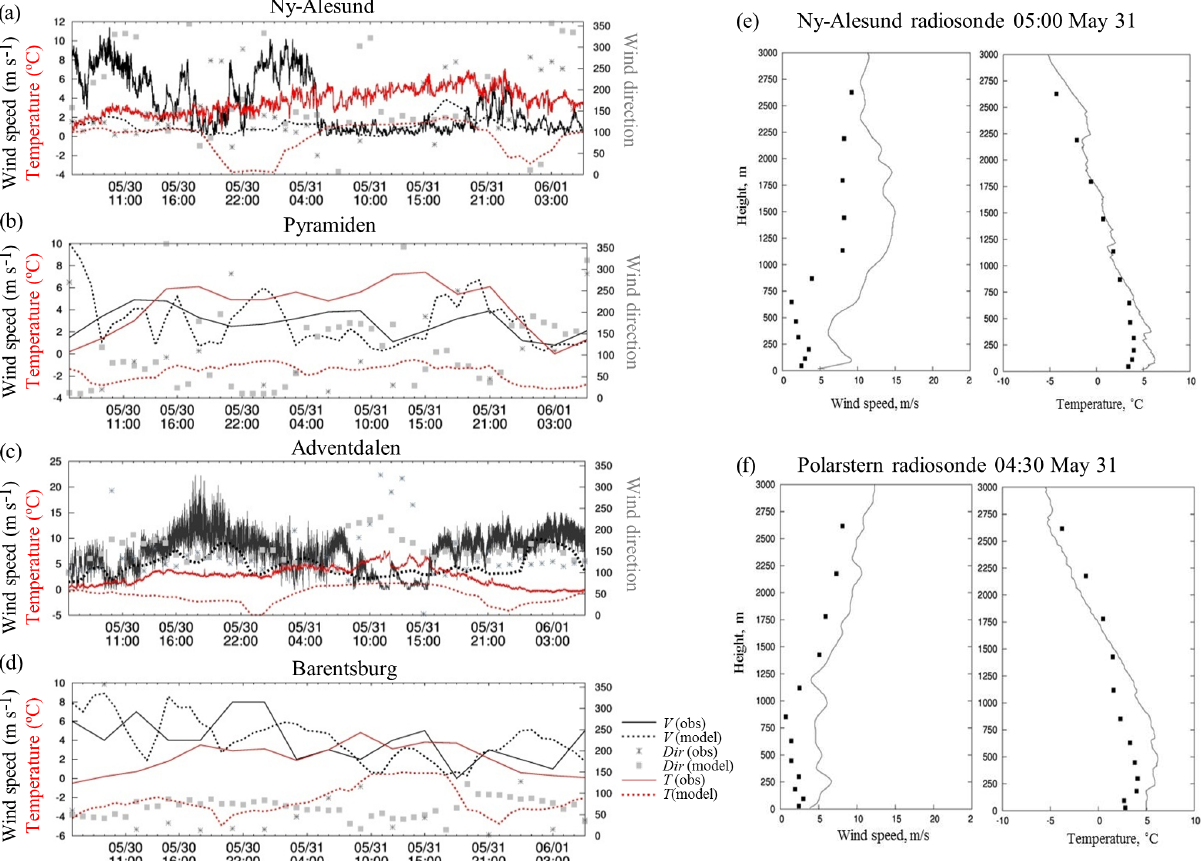
Figure A1. WRF model verification against AWS (a–d) and radiosonde data in Ny-Ålesund (e) and Polarstern (f) . (a–d) 10m wind speed V (black lines), 2m temperature T (red lines) and wind direction Dir (asterisks and squares) according to AWS observations (solid lines and asterisks) and WRF simulation (dotted lines and squares). Wind speed at Adventdalen station was measured with a sonic anemometer at 2.7ma.g.l. (e, f) Wind speed (left) and temperature (right) according to observations (solid line) and WRF simulation